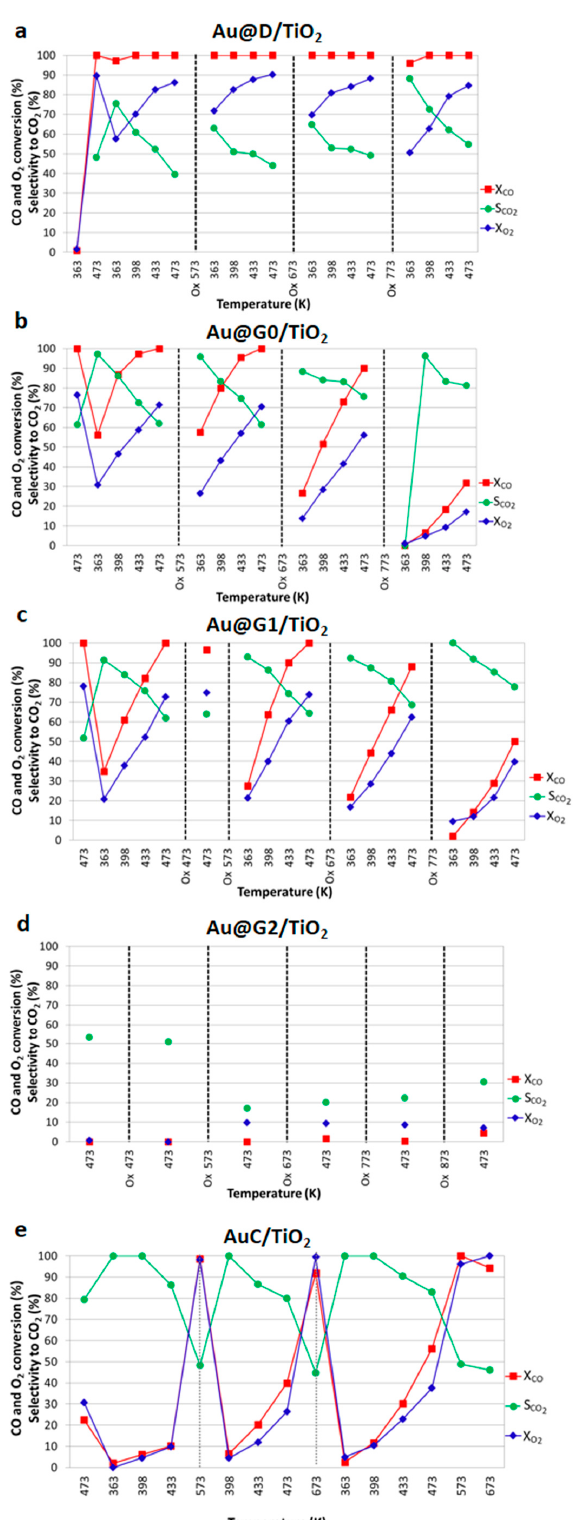
Figure 5. Temperature dependence performance of ( a ) Au@D/TiO 2 , ( b ) Au@G0/TiO 2 , ( c ) Au@G1/TiO 2 , ( d ) Au@G2/TiO 2 , and ( e ) AuC/TiO 2 catalysts for mixture B (2 vol.% CO, 2 vol.% O 2 , 2 vol.% H 2 , 94 vol.% Ar). Black vertical lines in ( a – d ) indicate the oxidations performed; grey lines in ( e ) show when mixture B was dosed at higher